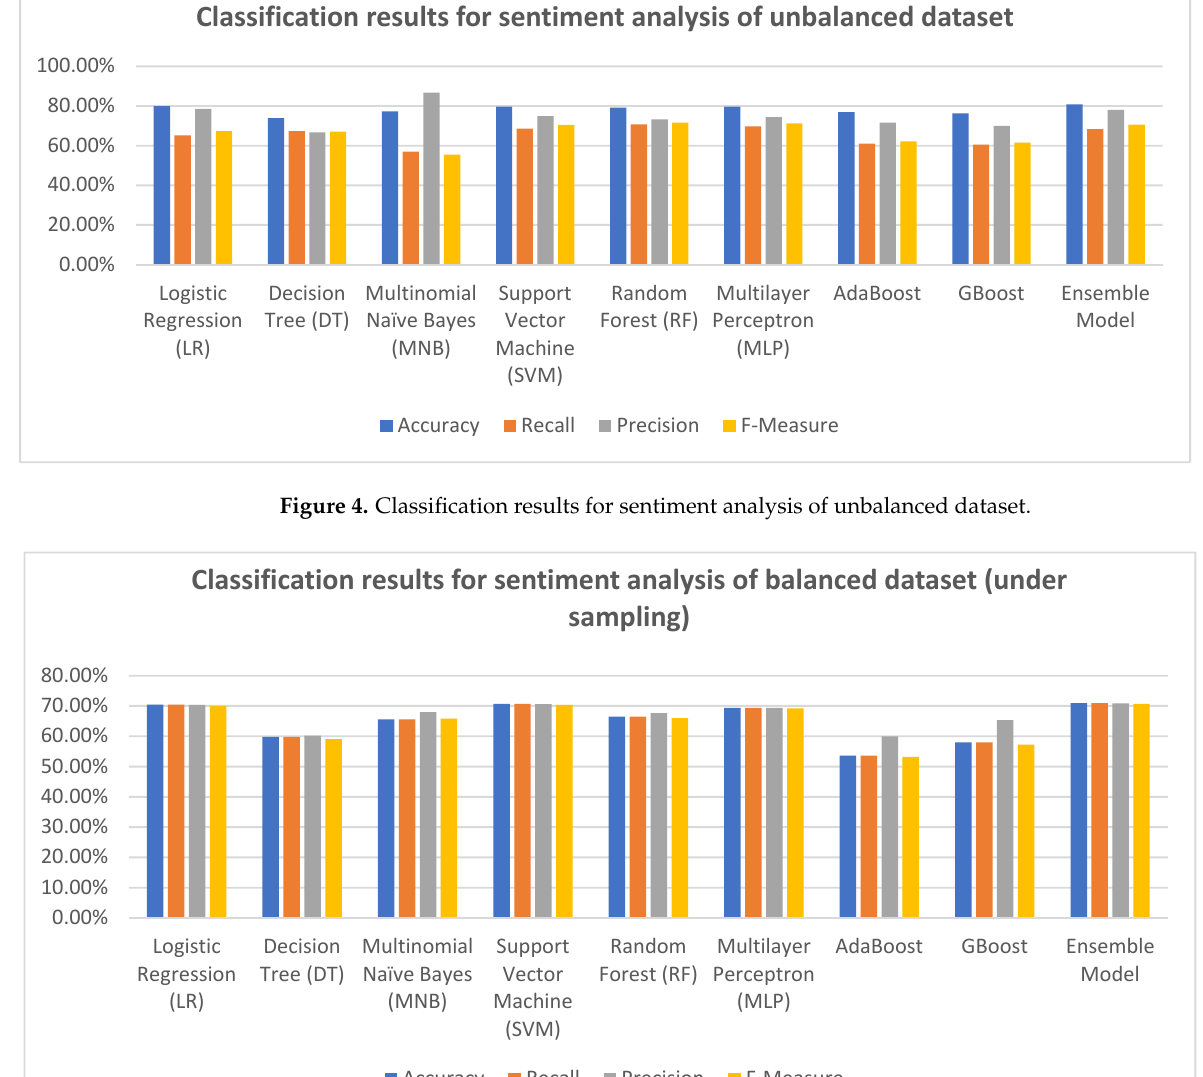
Table 7. Classification results for sentiment analysis of balanced dataset (undersampling). Balanced Dataset (Undersampling) (Features Extraction: